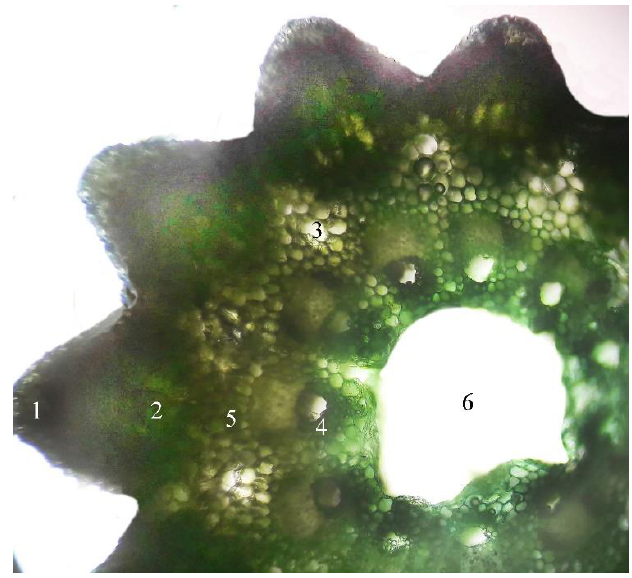
Figure 1. Equisetum arvense L. main stem cross section (100X): 1 — chlorenchyma; 2 — assimilated palisade parenchyma; 3 — aeriferous areas in the ground tissue, known as vallecular canals; 4 — vascular bundles; 5 — cortical parenchyma; 6 — pith cavity.